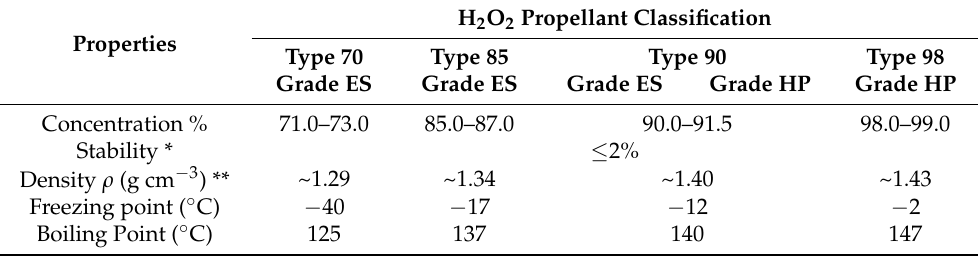
Table 7. Physical and chemical properties of H 2 O 2 propellant with different concentrations [77,88].